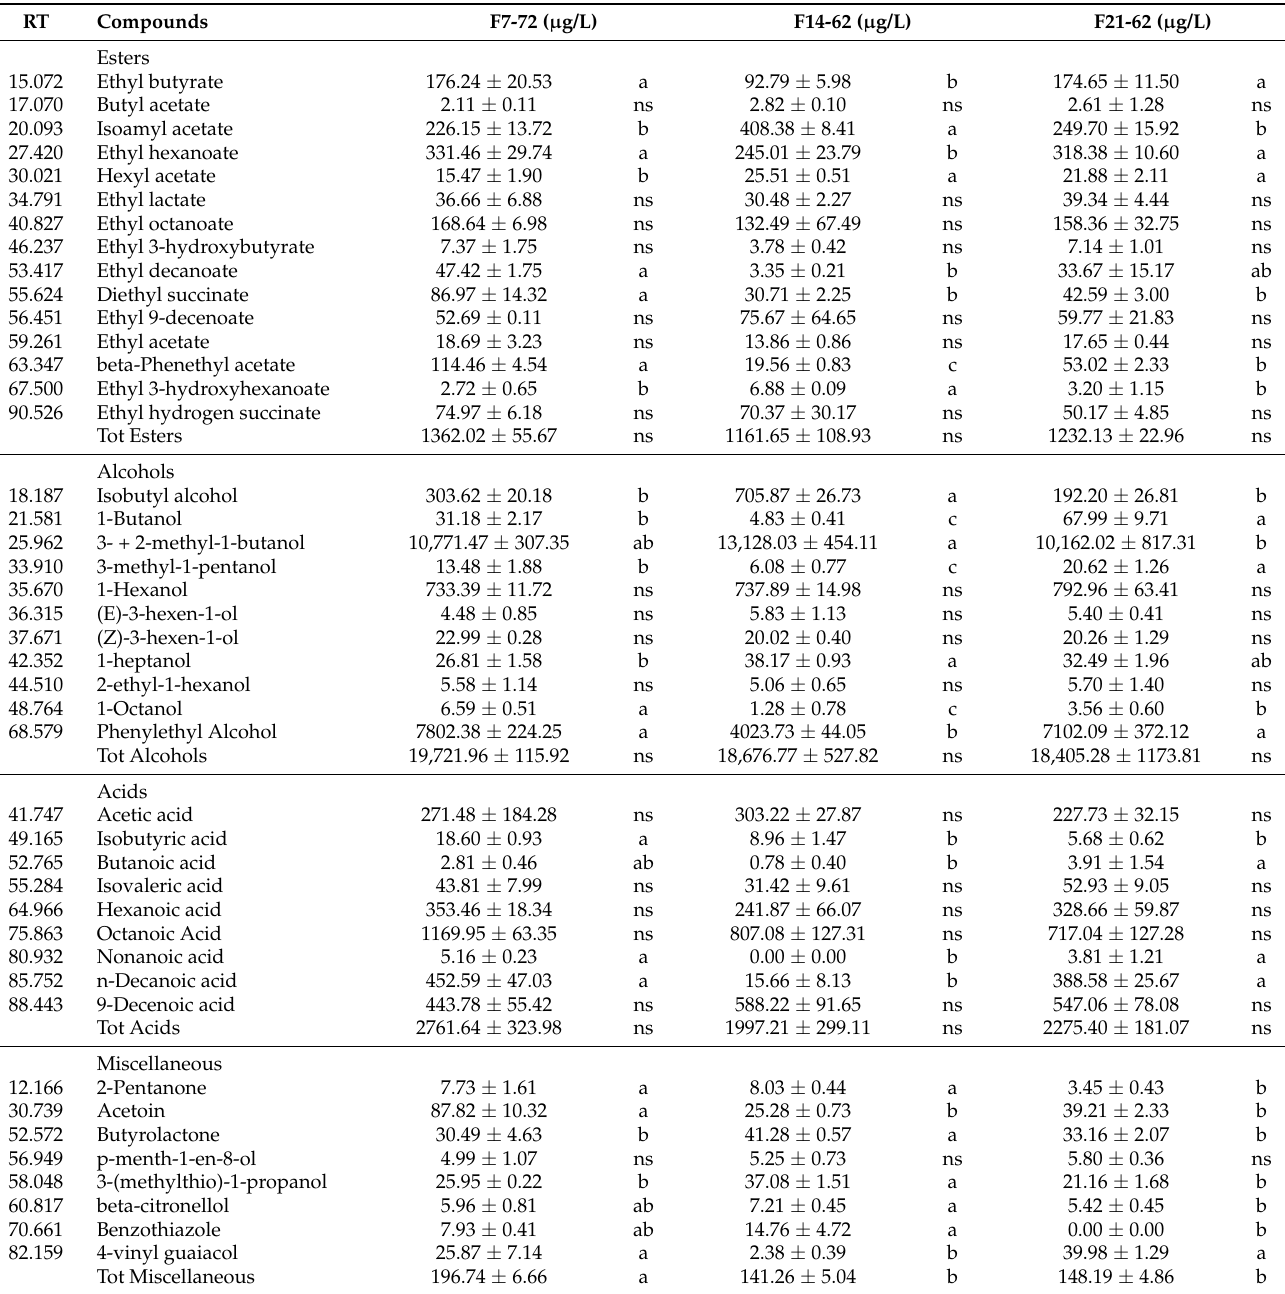
Table 5. Volatile compounds detected in S. kudriavzevii (F7-72), S. cerevisiae (F14-62), and S. paradoxus (F21-62) fermented wine